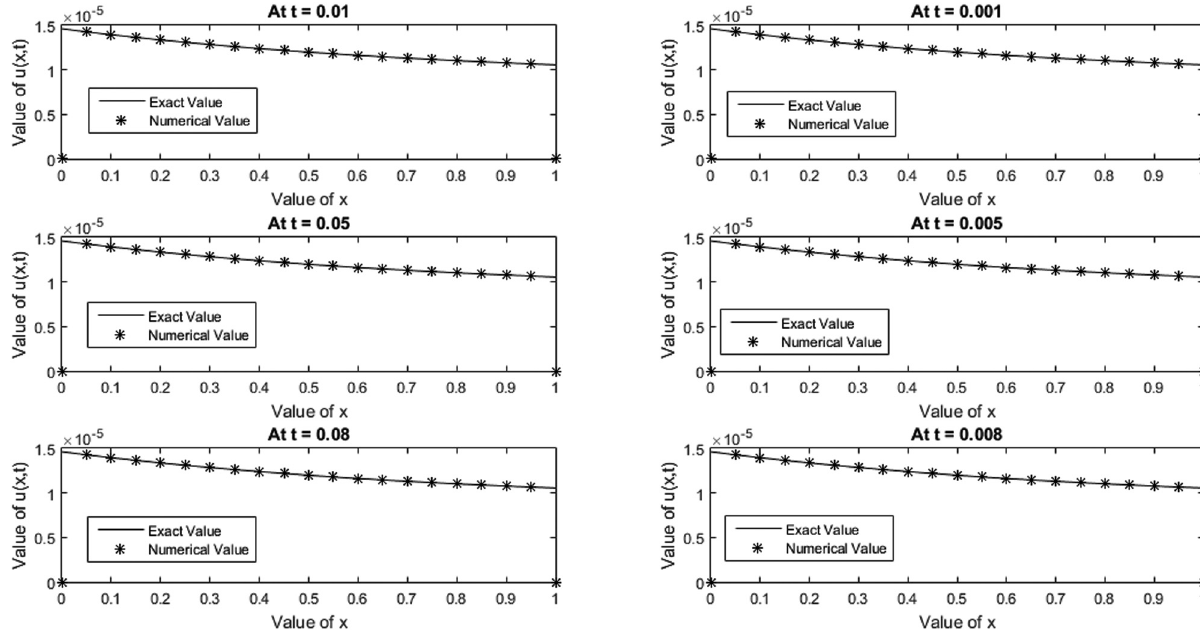
Figure 4: Pictorial depiction of solutions for = N 21 , = t Δ